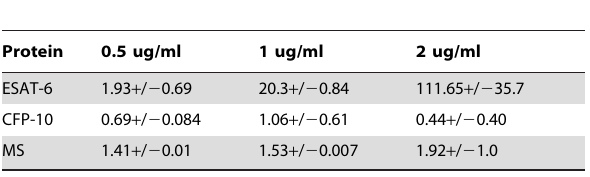
Table 3. Fold increase in U1 p24 production induced by M. tb recombinant